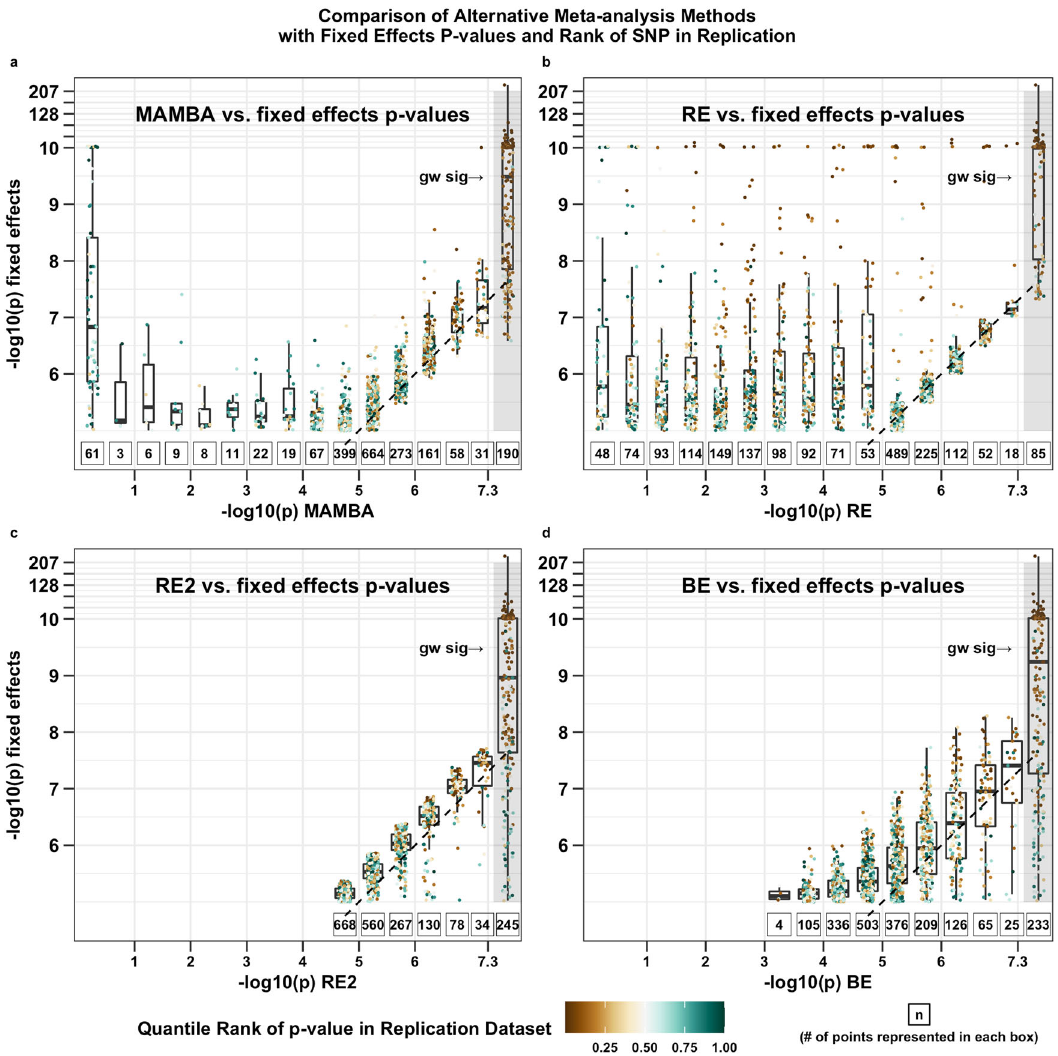
Fig. 4 Comparison of the p-values from MAMBA, RE, RE2, and BE meta-analysis with that of a fi xed effects meta-analysis combined across all GSCAN addiction phenotypes in the discovery cohorts. Each panel includes two-sided unadjusted p-values for 1,982 SNPs which were signi fi cant at P <1×10 − 5 from a fi xed effect meta-analysis and also tested in the replication dataset. We compare the p-values of fi xed effect meta-analysis with those obtained from ( a ) MAMBA, ( b ) RE, ( c ) RE2, and ( d ) BE methods. The variants are colored by their p-values in the replication cohort, with brown dots indicating SNPs with the most signi fi cant replication p-values. The gray shaded region labeled ‘ gw-sig ’ indicates where the alternative method to fi xed effects meta-analysis produces meta-analysis p-values < 5×10 − 8 . The number of variants represented in each boxplot is denoted underneath the boxplot. Each boxplot denotes 25th percentile, median, and 75th percentiles with whiskers extending by 1.5 times the inter-quartile range below and above the 25th and 75th percentiles. For SNPs with more signi fi cant replication p -values, MAMBA produces similar results as fi xed effect meta-analysis in the discovery cohorts. For SNPs with insigni fi cant replication p- values, MAMBA produced much more conservative p -values in the discovery cohorts. Source data are provided as a Source Data fi